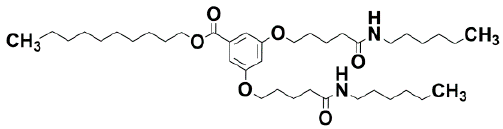
Figure A3. BHPB-10; number 10 stands for the number of carbons in the aliphatic arm. For synthesis see reference [36].